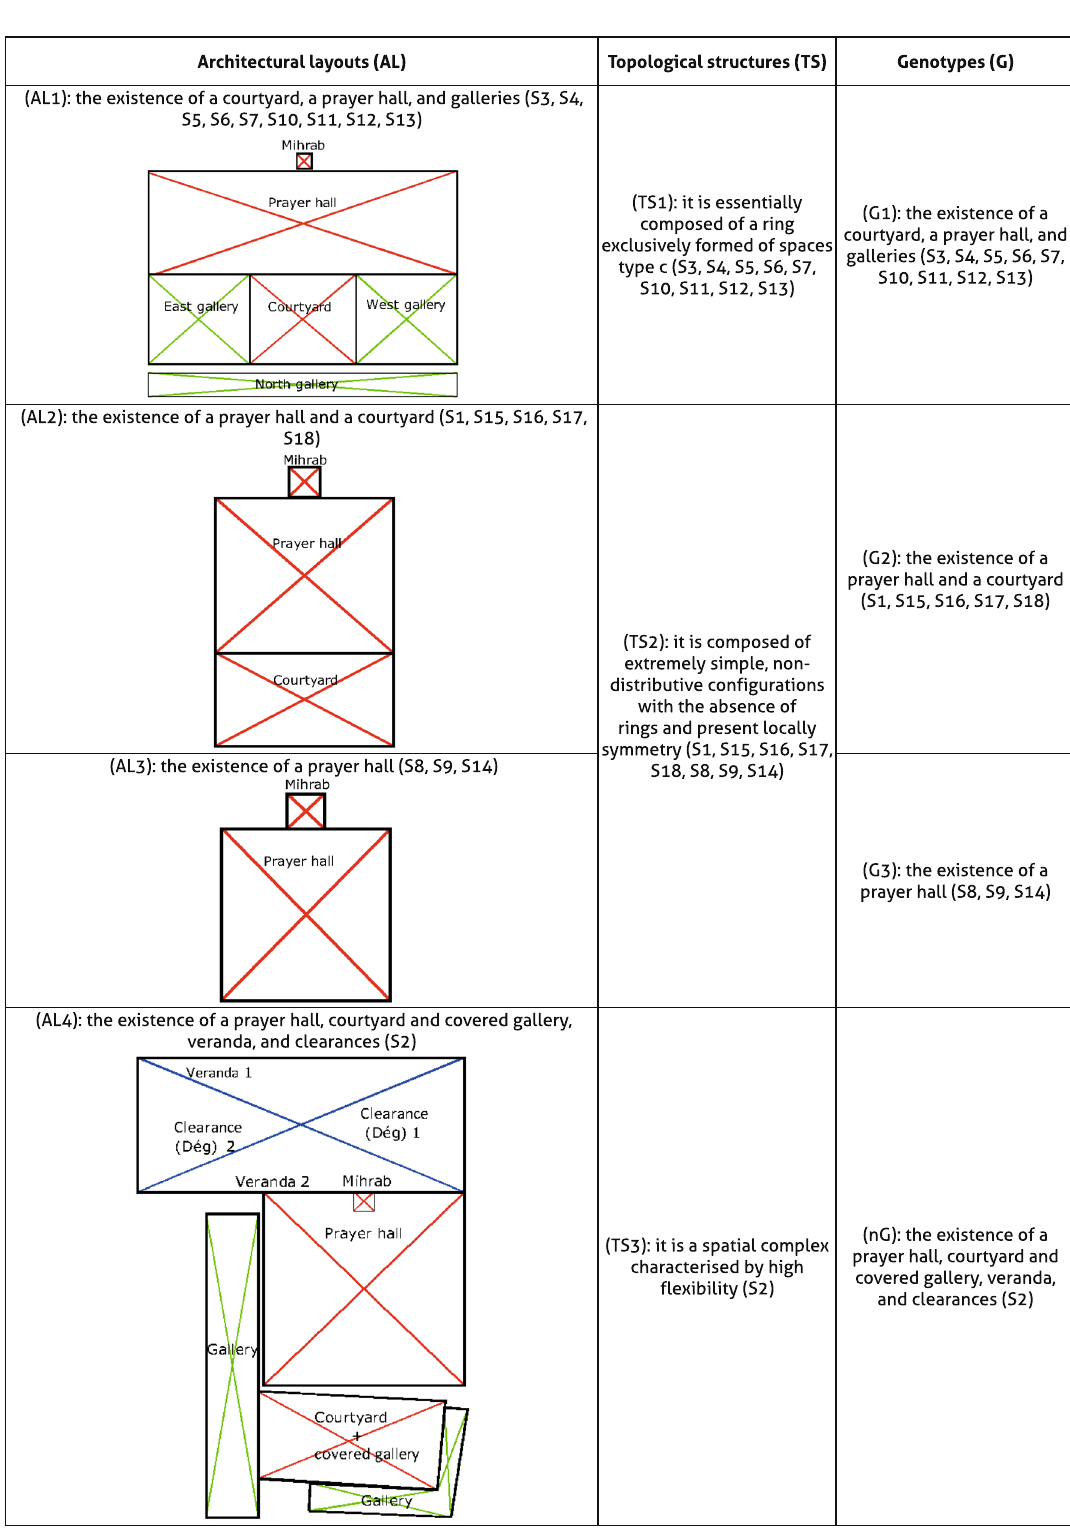
Fig. 13 Comparison between architectural layout (AL), topological structure (TS) and genotype (G) of mosques (Source: the